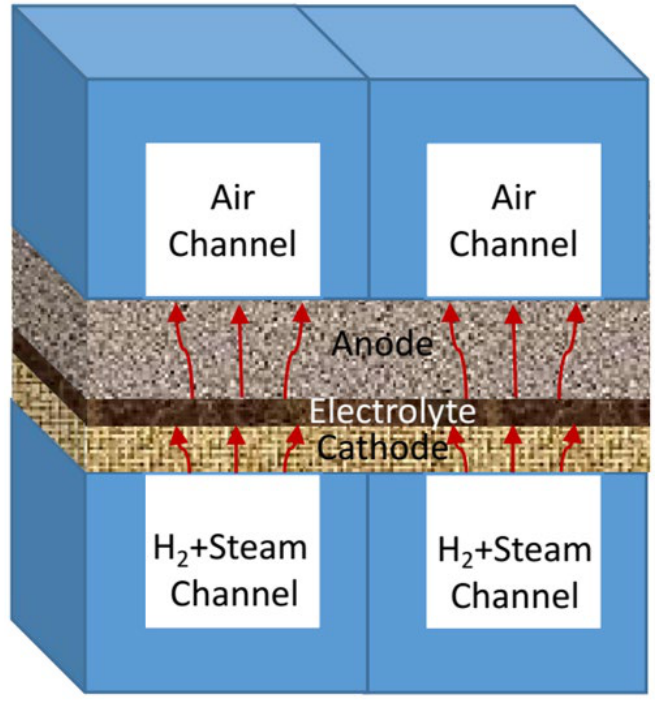
Figure 1. A typical planar SOEC stack-unit scheme. Unlike the conventional SOEC channel design, the rib and channel width of the novel opposite trapezoidal design varies along the flow direction. The channels become wider in the middle of each section, and the ribs become narrower. This feature has the potential to produce uneven flow in order to enhance the direct exposure of reactants to the electrodes without affecting the cell’s active area. More importantly, the novel design can increase reactant diffusion into the electrodes by changing the flow velocity and pressure along each channel. The potential benefits of the novel channels are investigated in terms of higher current densities and more efficient reactant distributions inside the SOEC. This novel design has more positive effects on the SOEC’s performance and